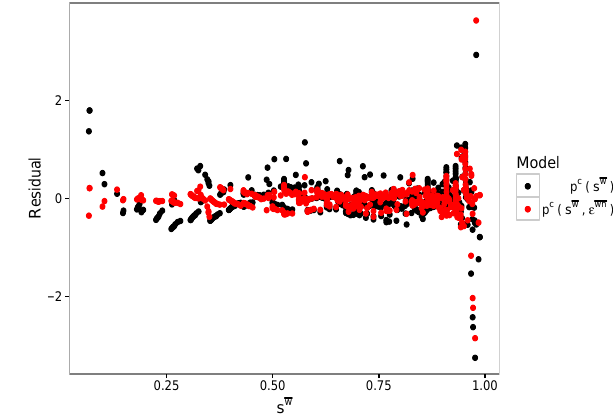
Figure 4. Contour plot showing the relationship p wn (s w , (cid:15) wn ) , with contours showing the capillary pressure p wn (kPa). Data points used to construct the surface are also shown, including randomly initial- ized fluid configurations and experimentally initialized configura- tions from primary drainage.